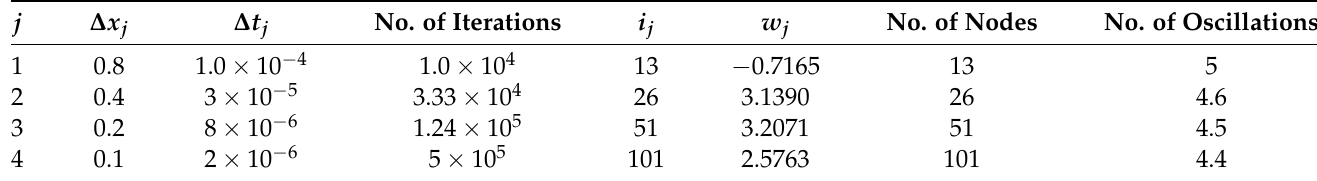
Table 3. Second Grid Convergence Index calculations.